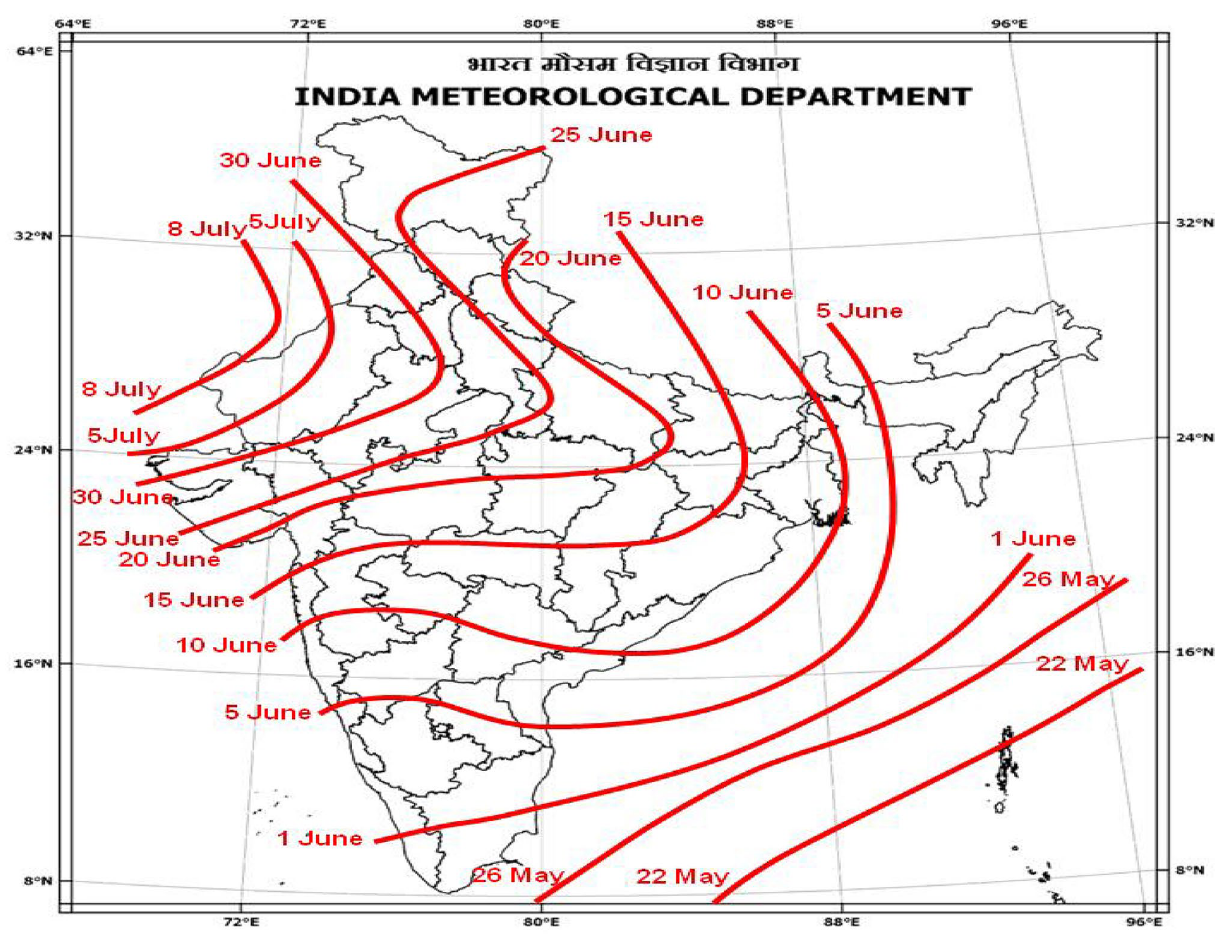
Fig. 1 Climatological normal dates and isochrones of onset of southwest monsoon